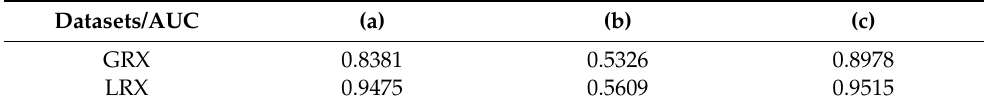
Figure 4. NSST subbands and difference band in the HSI band. ( a ) HSI band; ( b ) Low-frequency subband; ( c ) Difference band; ( d ) Anomaly detection reference map; ( e ) High-frequency subband in direction 1; ( f ) High-frequency subband in direction 2; ( g ) High-frequency subband in direction 3; ( h ) High-frequency subband in direction 4. Table 1. Parameters of RX